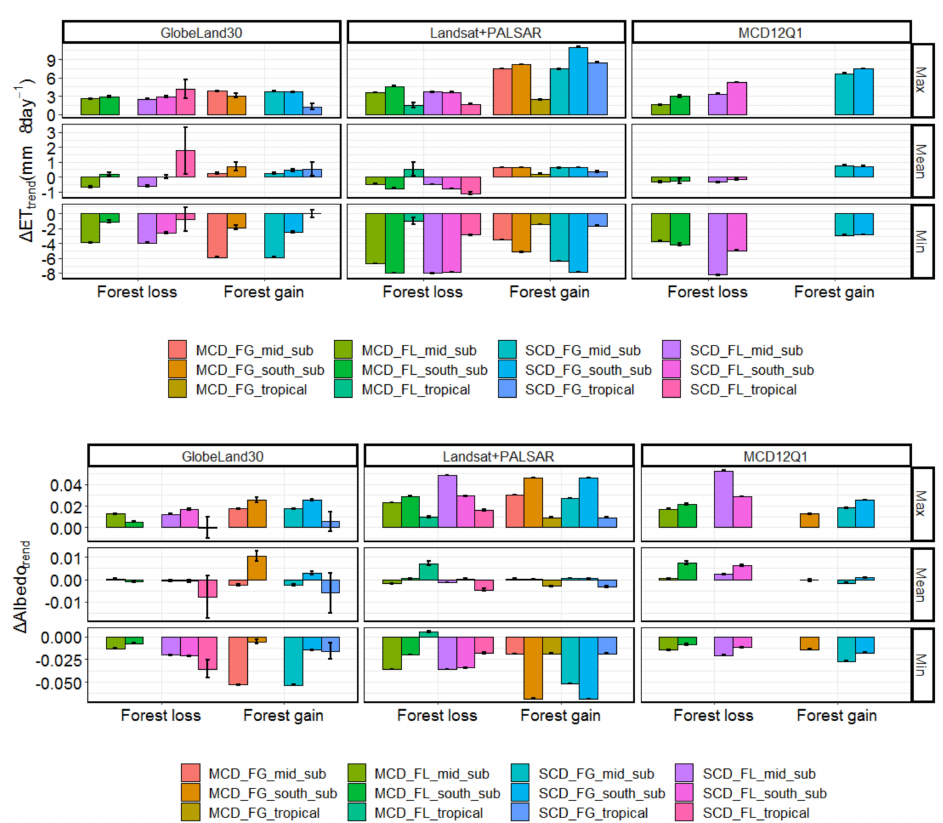
Figure 10. Annual ET and albedo di ff erences from 2000–2010 caused by three dataset-based forest losses and gains estimated by MCD and adjusted SCD over three climate zone-based forest areas in Guangdong Province, China. The vertical lines on each bar represent the confidence interval at 95% estimated by t